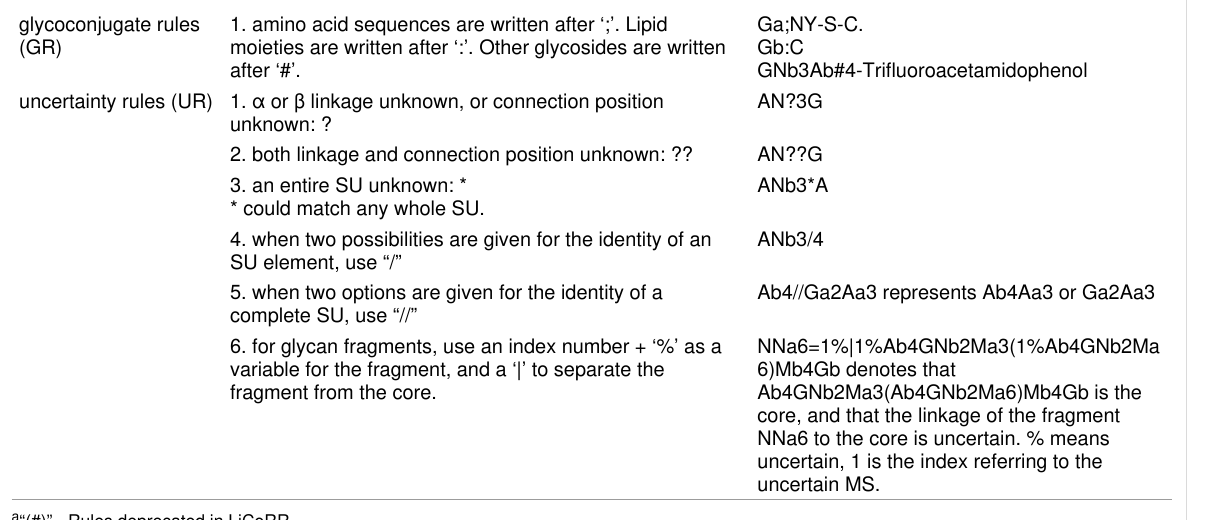
Table 3: Original Linear Code rules (Banin et al. [31]). a (continued) glycoconjugate rules